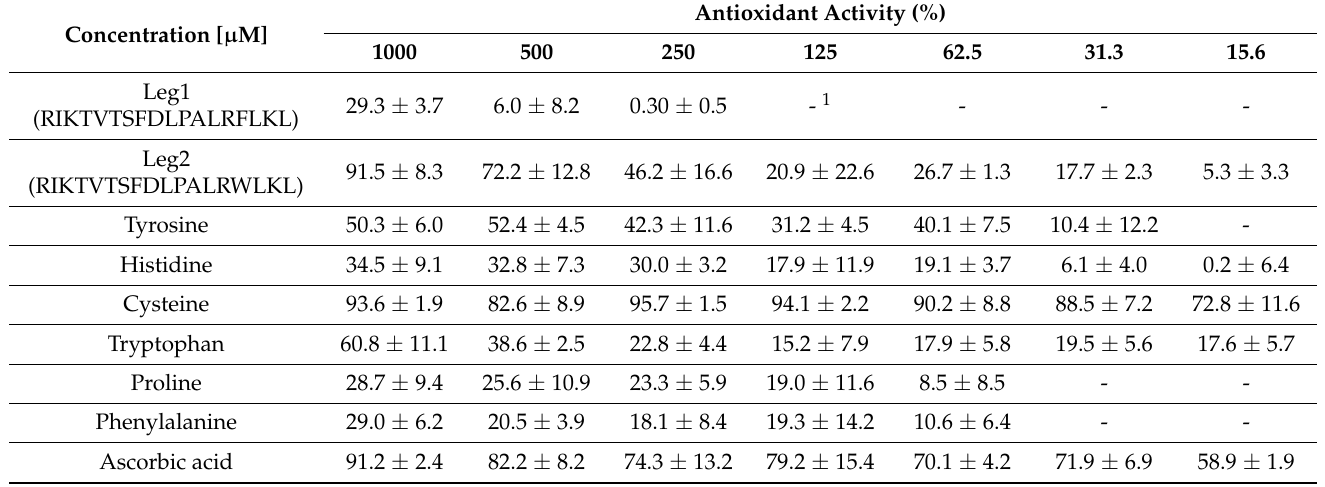
Table 3. Results of the antioxidant DPPH assay using Leg1/Leg2 and single amino acids in a concentration range of 15.6–1000 µ M. Ascorbic acid was used as positive control. The mean ± SD of triplicates of the antioxidative activity is displayed.